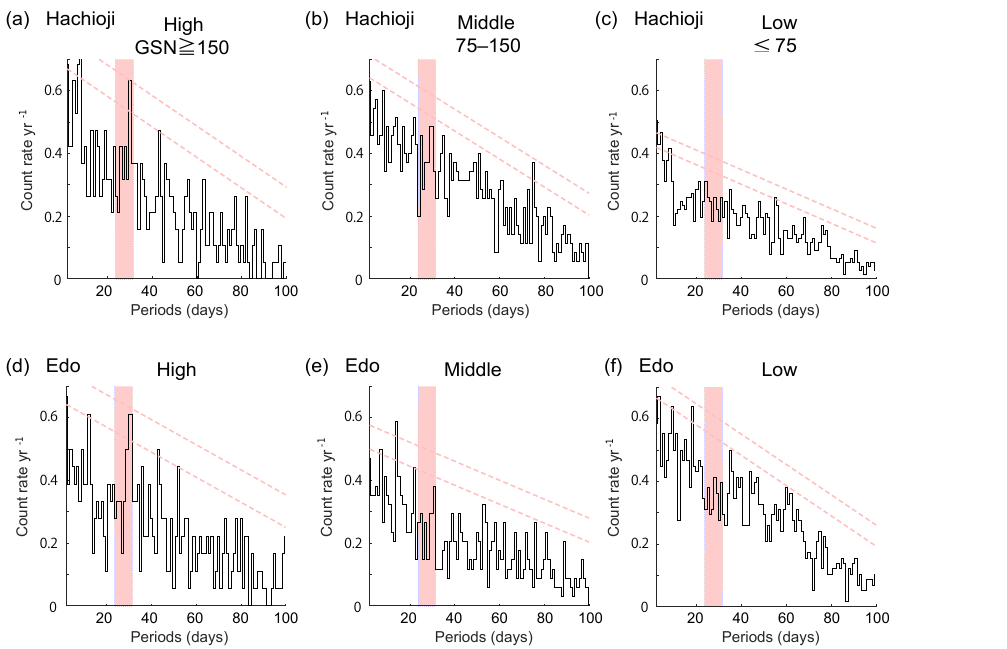
Figure 3. Periodicity of the thunder/lightning events from May to September in (a–c) Hachioji and in (d–f) Edo in the 18th to 19th centuries. Histograms were obtained for the periods when the GSNs were (a, d) greater than or equal to 150, (b, e) from 75 to 150, and (c, f) less than 75. The red dashed lines denote 2.0 and 3.0 SDs. The red shaded bars indicate the 24–31 day